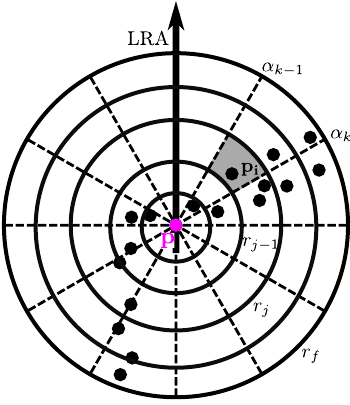
Figure 1. Segmentation of the local spherical support of the query point p into spatial bins along the radial and elevation direction. Point p i is assigned to the spatial bin F k j (depicted with grey background